Question: Which kind of chart has been used to present this data?
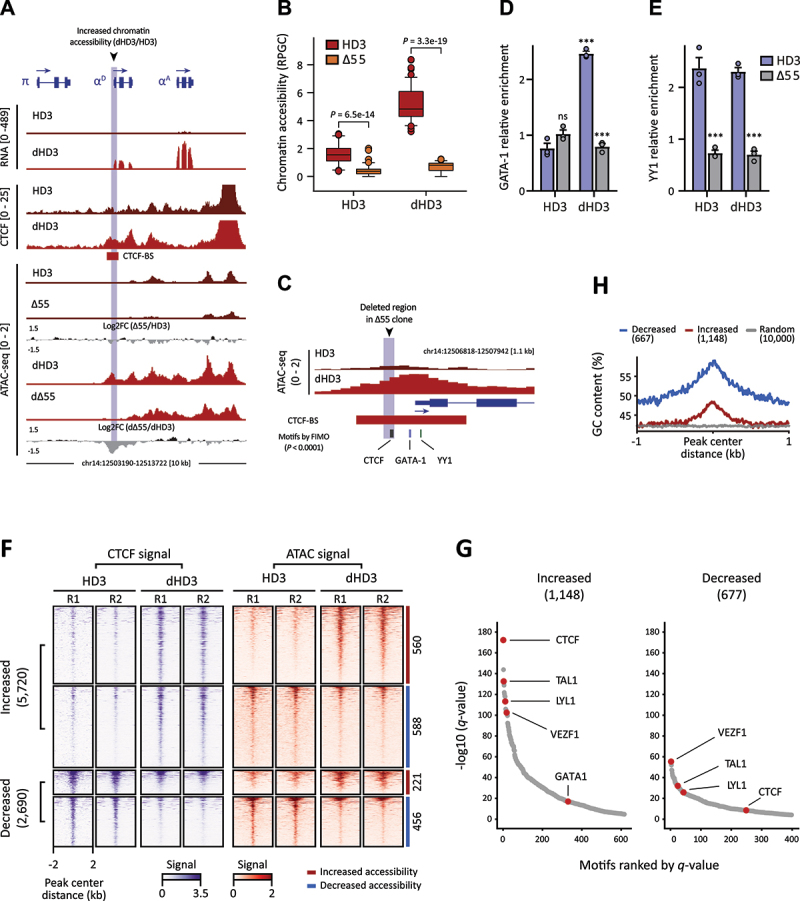
Answer: heatmap